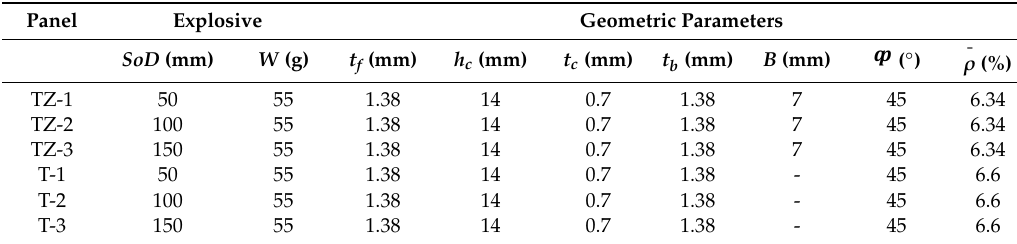
Table 1. Parameters of the sandwich panels. Table 1 . Parameters of the sandwich